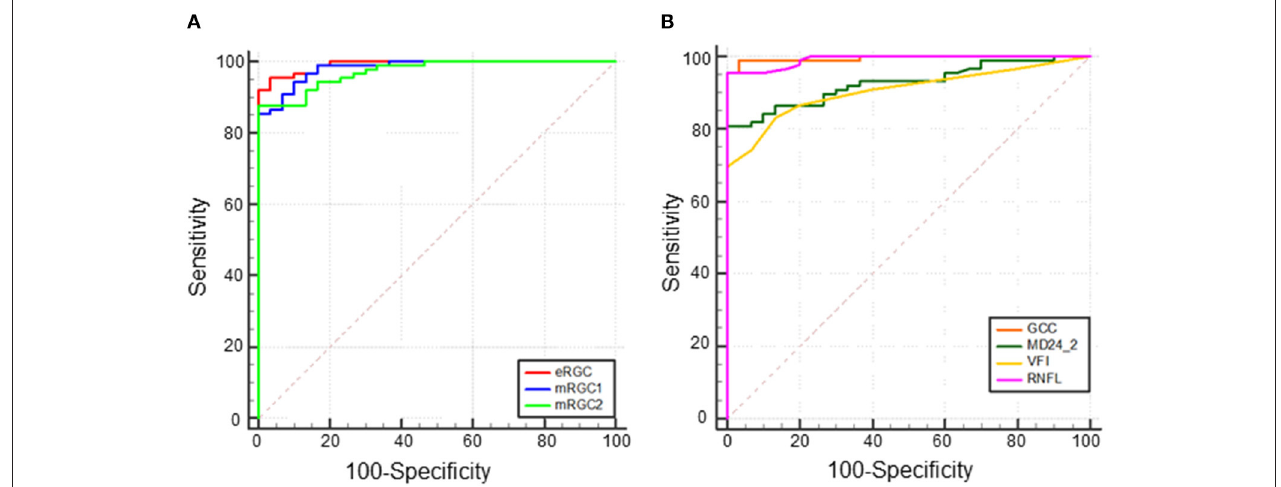
FIGURE 2 | Receiver operating characteristic (ROC) curve of total eRGC, mRGC1, and mRGC2 and structural/functional parameters in POAG, (A) Area under the ROC curve (AUC) of eRGC, mRGC1, and mRGC2 was 0.992 (95% CI, 0.954 ∼ 1.000), 0.982 (95% CI, 0.939 ∼ 0.998), 0.972 (95% CI, 0.924 ∼ 0.994), respectively, and (B) AUC of ganglion cell complex (GCC), retinal nerve fiber layer (RNFL), visual field index (VFI), and MD (24-2) was 0.995 (95% CI, 0.960 ∼ 1.000), 0.992 (95% CI, 0.954 ∼ 1.000), 0.906 (95% CI, 0.839–0.952), and 0.927 (95% CI, 0.865–0.967), respectively.